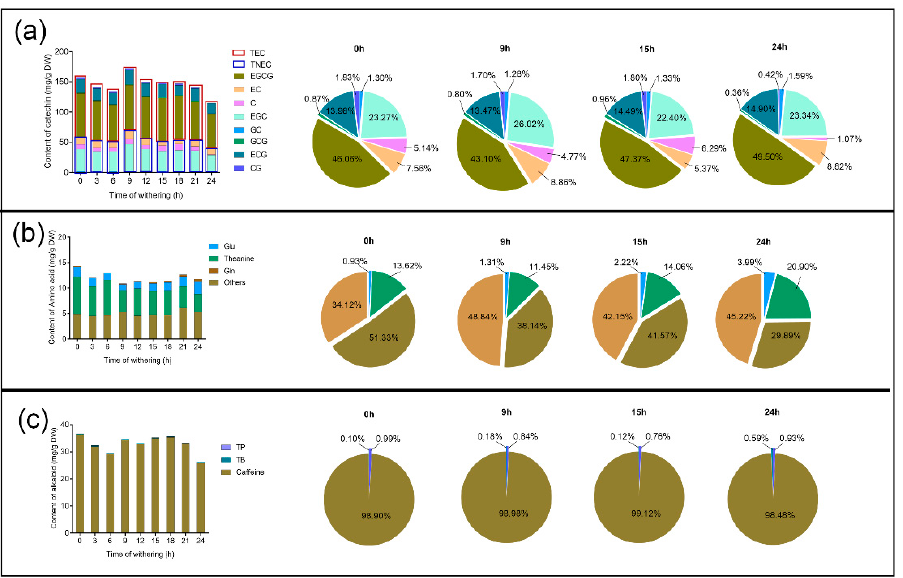
Figure 2. Changes in the content and proportion of catechins ( a ), theanine ( b ), and caffeine ( c ) at different stages of the withering process. The total height of each column and the total area of each pie chart both indicate the total amount of 8 catechins, all amino acids, including theanine, and all alkaloids, including caffeine. C, catechin; CG, catechin gallate; EC, epicatechin; ECG, epicatechin gallate; EGC, epigallocatechin; GC, gallocatechin; GCG, gallocatechin gallate; ECGC, epigallocatechin gallate; TEC, total content of ester catechins; TNEC, total content of non-ester catechins; Glu, glutamate; Gln, glutamine; TB, theobromine; TP, theophylline.